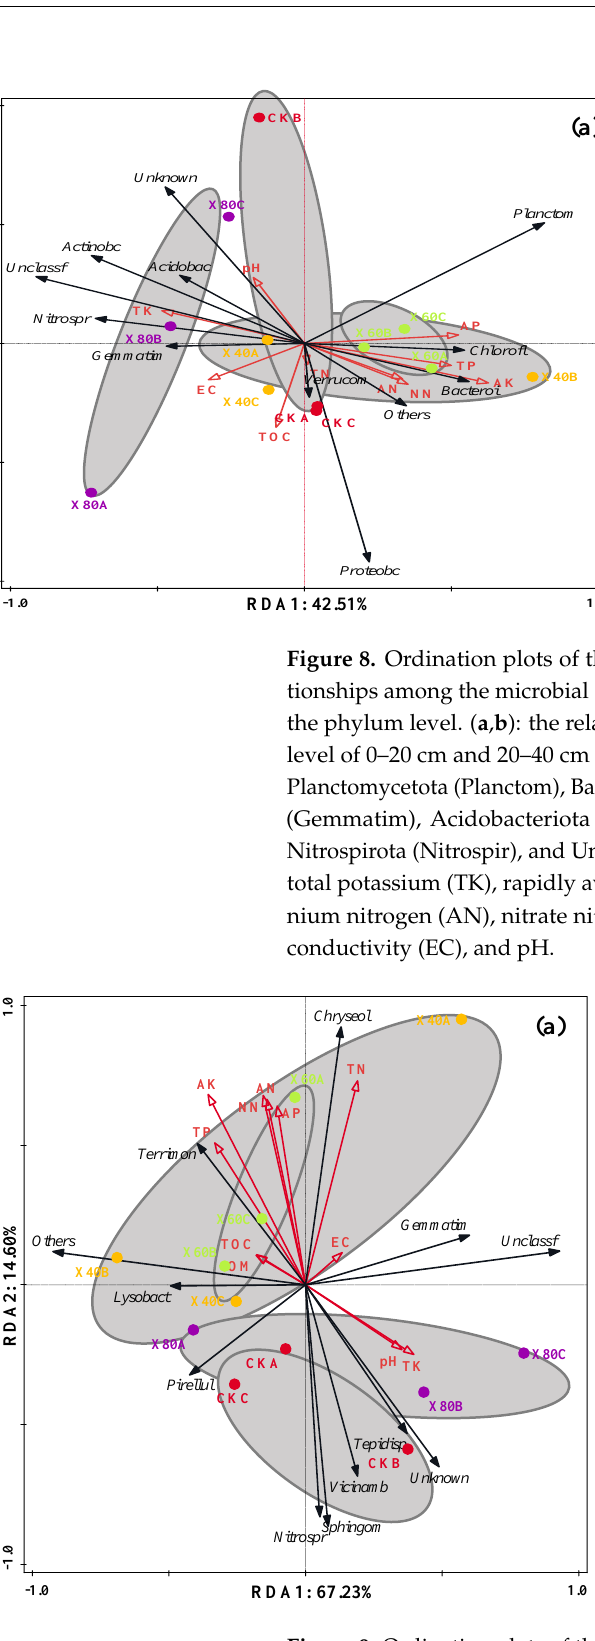
Figure 9. Ordination plots of the results from the redundancy analysis (RDA) to identify the relationships among the microbial (bacterial) taxa (black arrows) and the soil properties (red arrows) at the genus level. ( a , b ): the relationship among the soil bacterial taxa and the soil properties at the level of 0 – 20 cm and 20 – 40 cm depth of soil, respectively. Bacterial taxa Vicinamibacter (Vicinamb), Sphingomonas (Sphingom), Tepidisphaera (Tepidisp), Gemmatimonas (Gemmatim), Nitrospira (Nitrospir), Pirellula (Pirellul), Terrimonas (Terrimon), Chryseolinea (Chryseol), Lysobacter